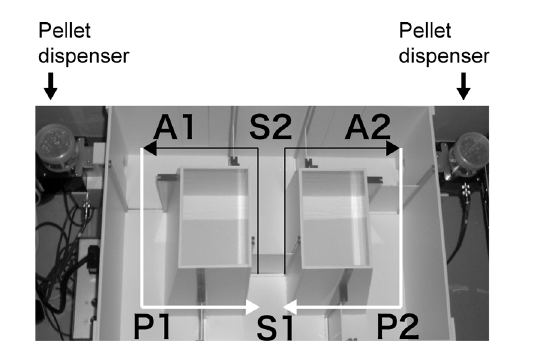
Figure 2 | Apparatus of T-maze forced alternation task